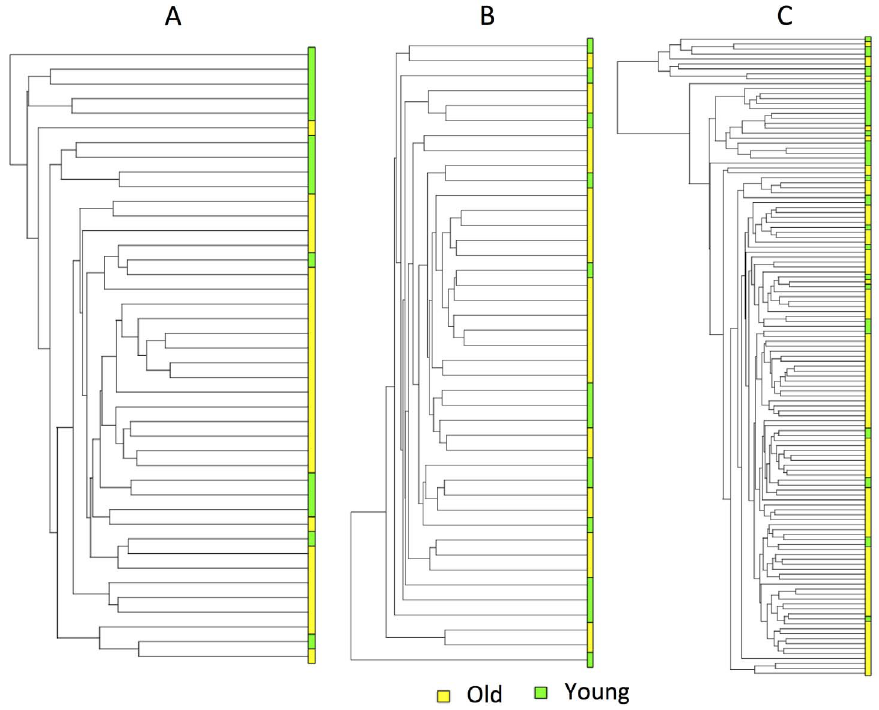
Figure 4. Hierarchical clustering of GBM samples in the REMBRANDT and TCGA data sets. (A) Clustering of old and young REMBRANDT GBM samples based on the expression profiles of age-specific genes derived from both TCGA Affymetrix U133A and Agilent G4502A data sets. (B) Clustering of old and young REMBRANDT GBM samples based on the expression profiles of all genes in the REMBRANDT data set. (C) Clustering of the old and young TCGA GBM samples based on the expression profiles of age-specific genes derived from both TCGA Affymetrix U133A and Agilent G4502A data sets.